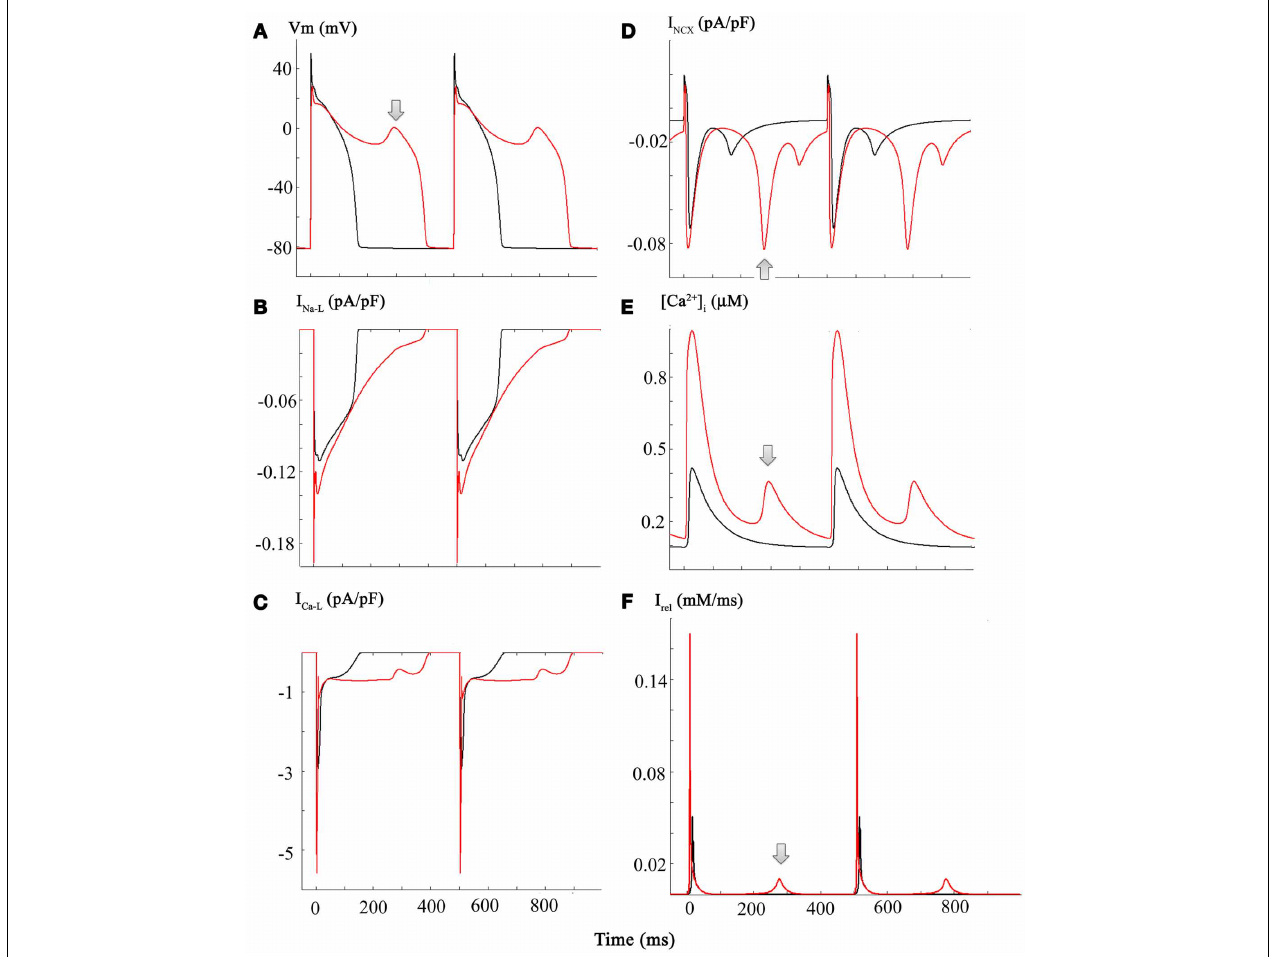
FIGURE 5 | Diagram illustrating a plausible mechanism for generation of EADs in our modified Grandi model of the human ventricular action potential. Panels (A through C) each consist of a pair of superimposed records for the AP, I Na - L , and I Ca - L records, respectively. Those in black correspond to control or baseline conditions, and the CO-induced changes are shown in red. Important new information is